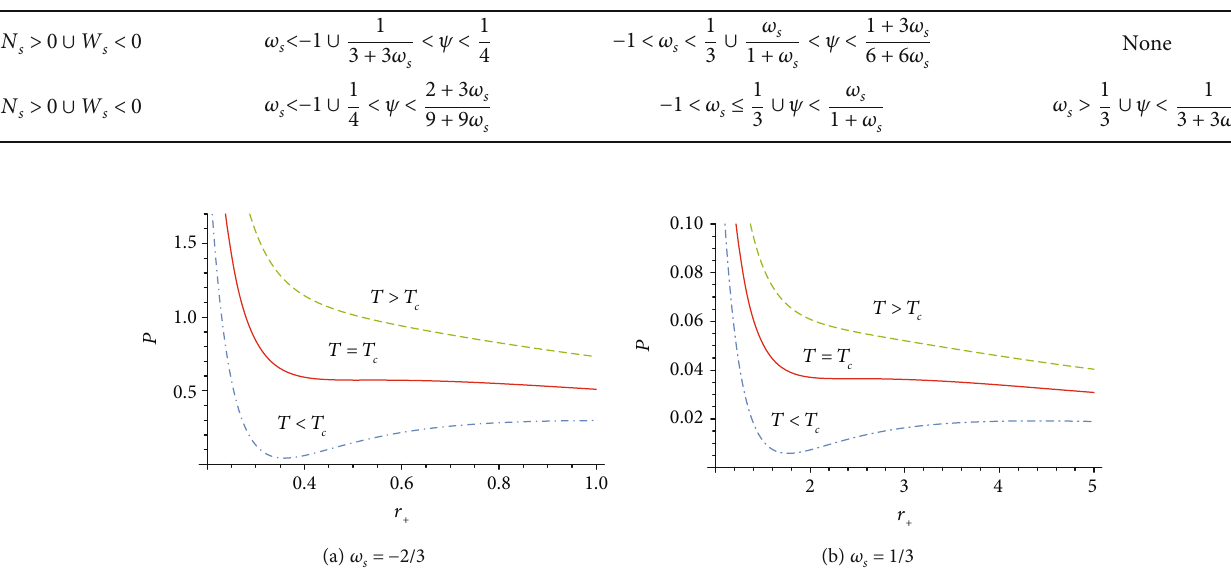
ψ = − 5/2 and N = − 1 . The upper dashed line corresponds to the Figure 1: The P − r + diagrams of four-dimensional AdS black holes with s . The critical temperature case T = T is denoted by the solid line. The line below is with temperatures idea gas phase behavior for T > T c c = 0 : 1610 in (a) and T = 0 : 0433 in smaller than the critical temperature. We have T c c